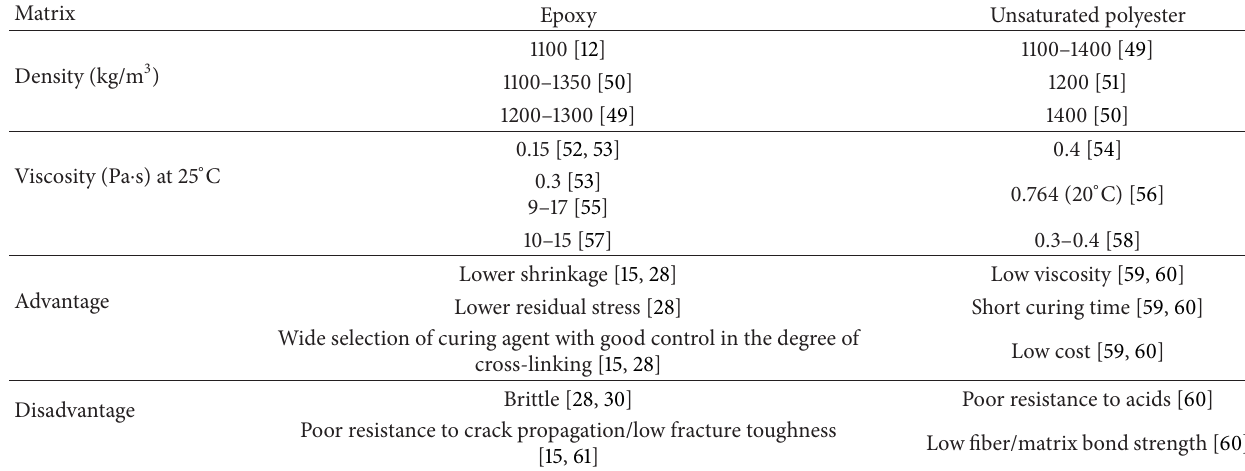
Table 1: Density, viscosity, advantages, and disadvantages of epoxy and unsaturated